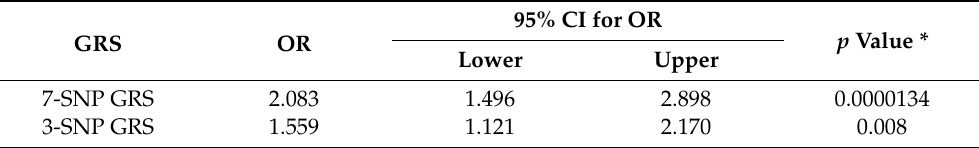
Table 3. Association of 7-SNP and 3-SNP GRSs with T2D. GRS